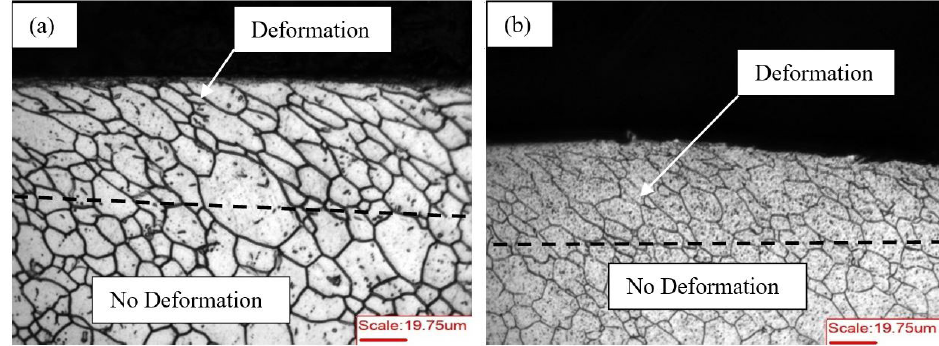
Figure 11. Sample Test (a) machined and (b) machined and polished. Electrolytic attack with 60% HNO